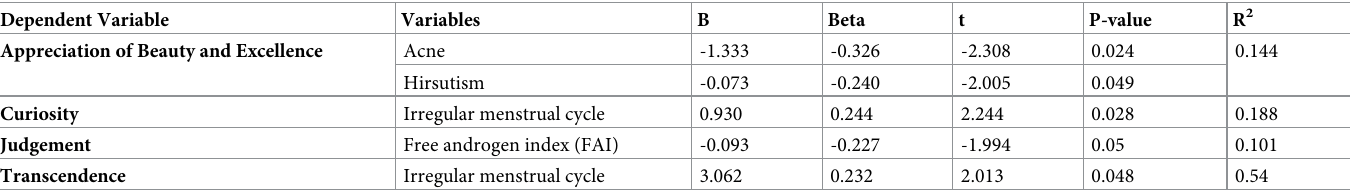
Table 4. Multiple linear regressions for the predictors of the 24 character strengths and 6 virtues between the two groups. Dependent